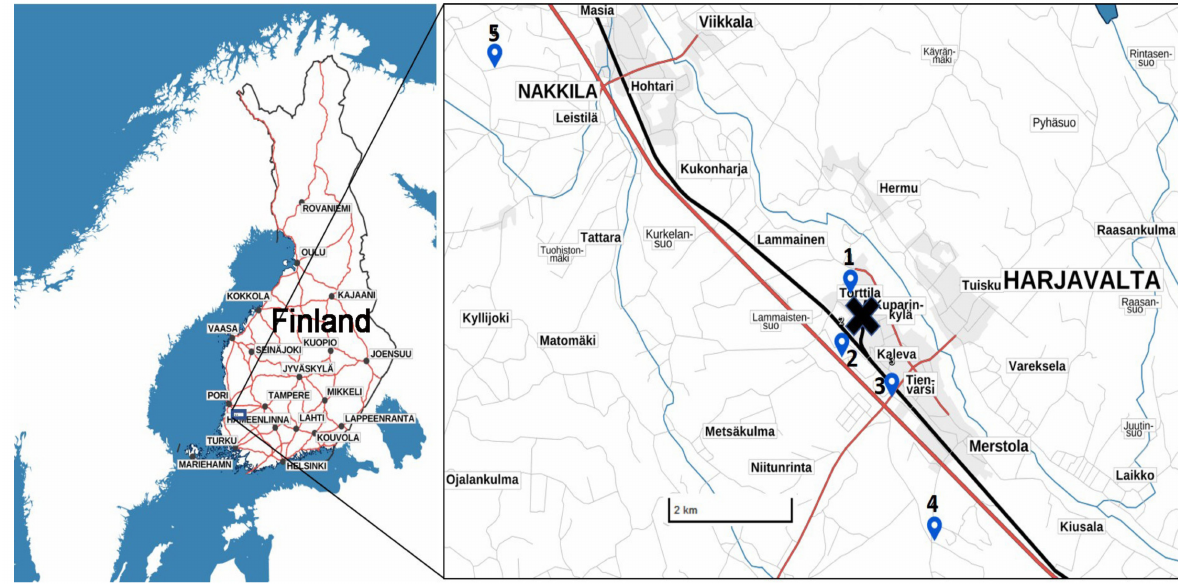
Figure 1. Map showing the location of sample collection. X indicates the position of the smelter, while Torttila (1), and Gate (2) indicate the high-polluted sites. Nummi (3) is the intermediate zone, while Hiite (4), and Nakkila (5) are the reference (low-polluted)